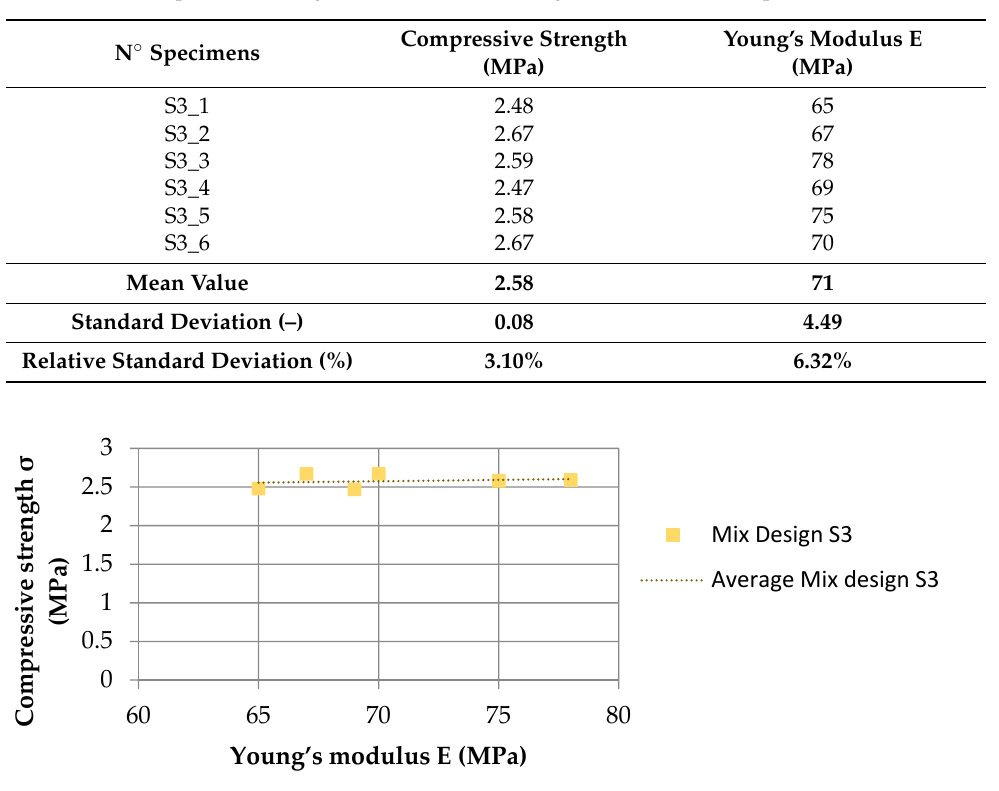
Table 4. The compressive strength values and the Young’s modulus E of S3 specimens.